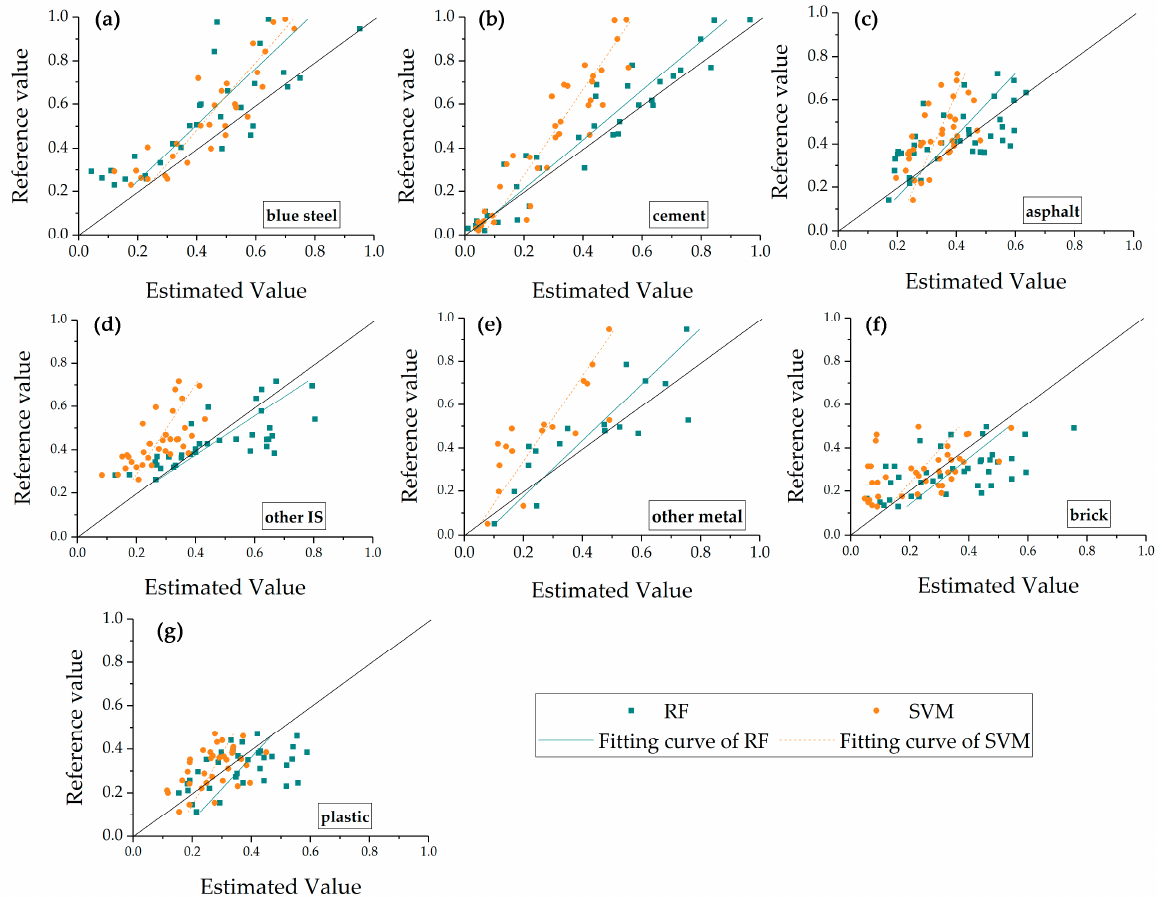
Figure 11. Linear relationship between the test values and the estimated values compared with RF and SVM ( a ) blue steel; ( b ) cement; ( c ) asphalt; ( d ) other impervious surface; ( e ) other metal; ( f ) brick; ( g ) plastic.